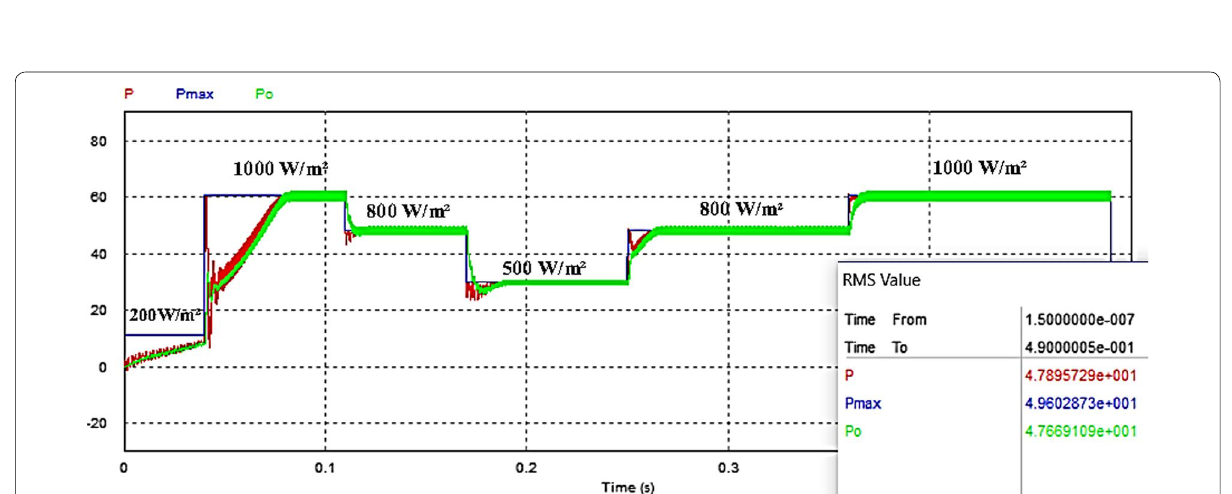
Fig. 12 Output powers for INC algorithm under variable solar